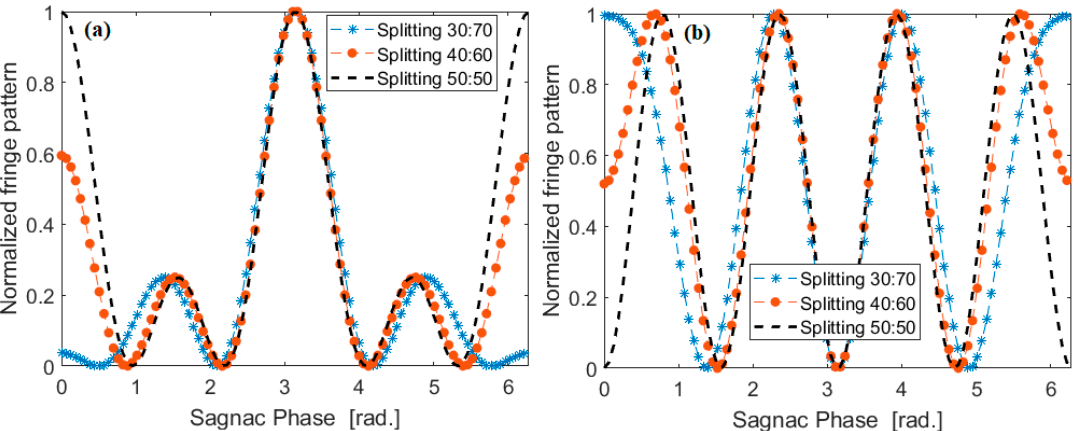
Figure 7. Normalized fringe pattern versus the Sagnac phase, for different values of the splitting ratio of BS-3 and BS-4; ( a ) architecture of Figure 1b; ( b ) architecture of Figure 1c.